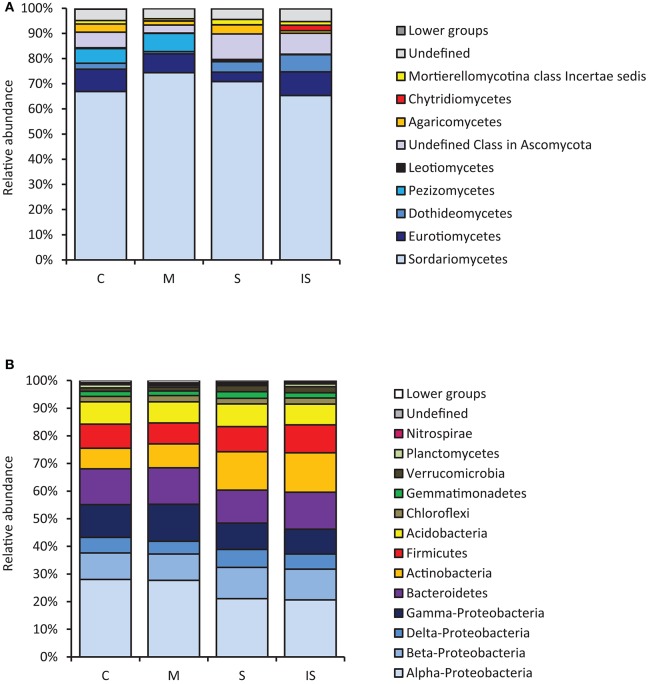
Relative abundance levels of fungal classes (A) and bacterial phyla (B), expressed as percentages of all sequences, detected in the conducive soil (C), mixed soil (M), suppressive soil (S), and pathogen-inoculated suppressive soil (IS).